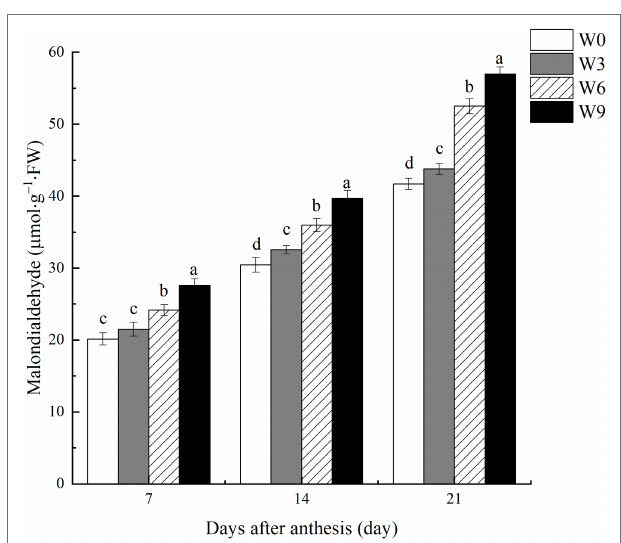
FIGURE 6 | MDA contents in wheat flag leaves under varying waterlogging durations. Data were collected at 7, 14, and 21 days after anthesis. W0 = control, W3 = 3 days of waterlogging, W6 = 6 days of waterlogging, W9 = 9 days of waterlogging. Vertical bars represent the mean of each treatment (six replicates across two years) ± SE (standard errors). Means carrying the same letter are not significantly different at the 5% level.